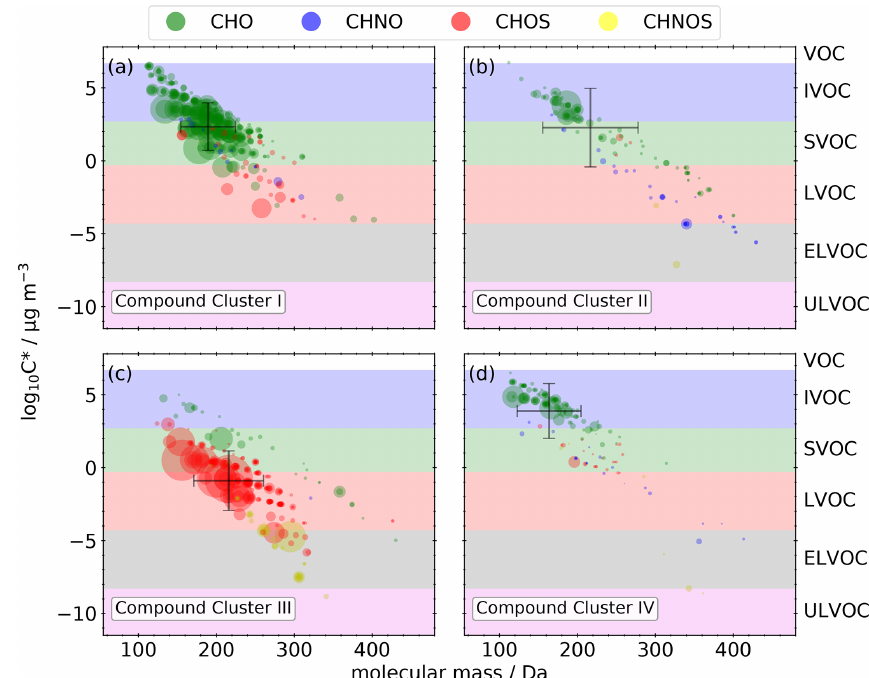
Figure 8. Calculated effective saturation mass concentrations of compounds appearing in compound clusters I–IV (a–d) with the intensity- weighted mean and standard